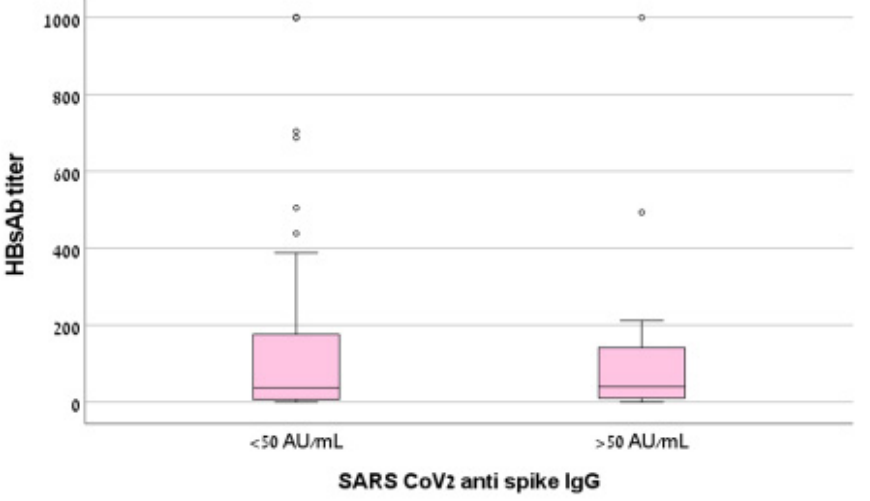
Figure 2. Box plot of HBsAb titer (mIU/mL) according to humoral response to BNT Pfizer vaccine. IgG S titer was not correlated with HBV titer (Spearman’s rho = 0.148, p = 0.155). HBV: hepatitis B virus; HbsAb: hepatitis B surface antibody.